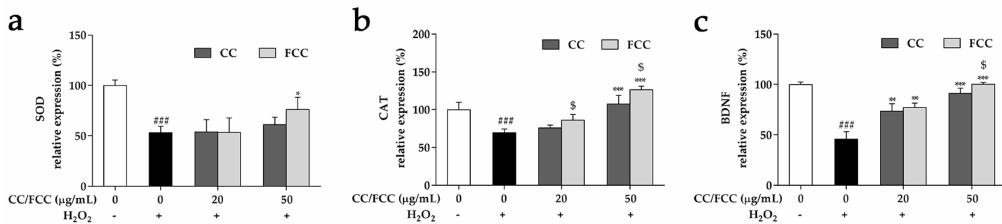
Figure 6. E ff ect of CC and FCC on antioxidant enzymes and neuronal stress marker in SH-SY5Y neuroblastoma cells. The antioxidant enzymes ( a ) superoxide dismutase (SOD), ( b ) catalase (CAT), and neuronal marker ( c ) brain-derived neurotrophic factor (BDNF) genes expression levels were detected by quantitative real-time PCR. “ + , -”: Cells were treated with or without H 2 O 2 . The data are